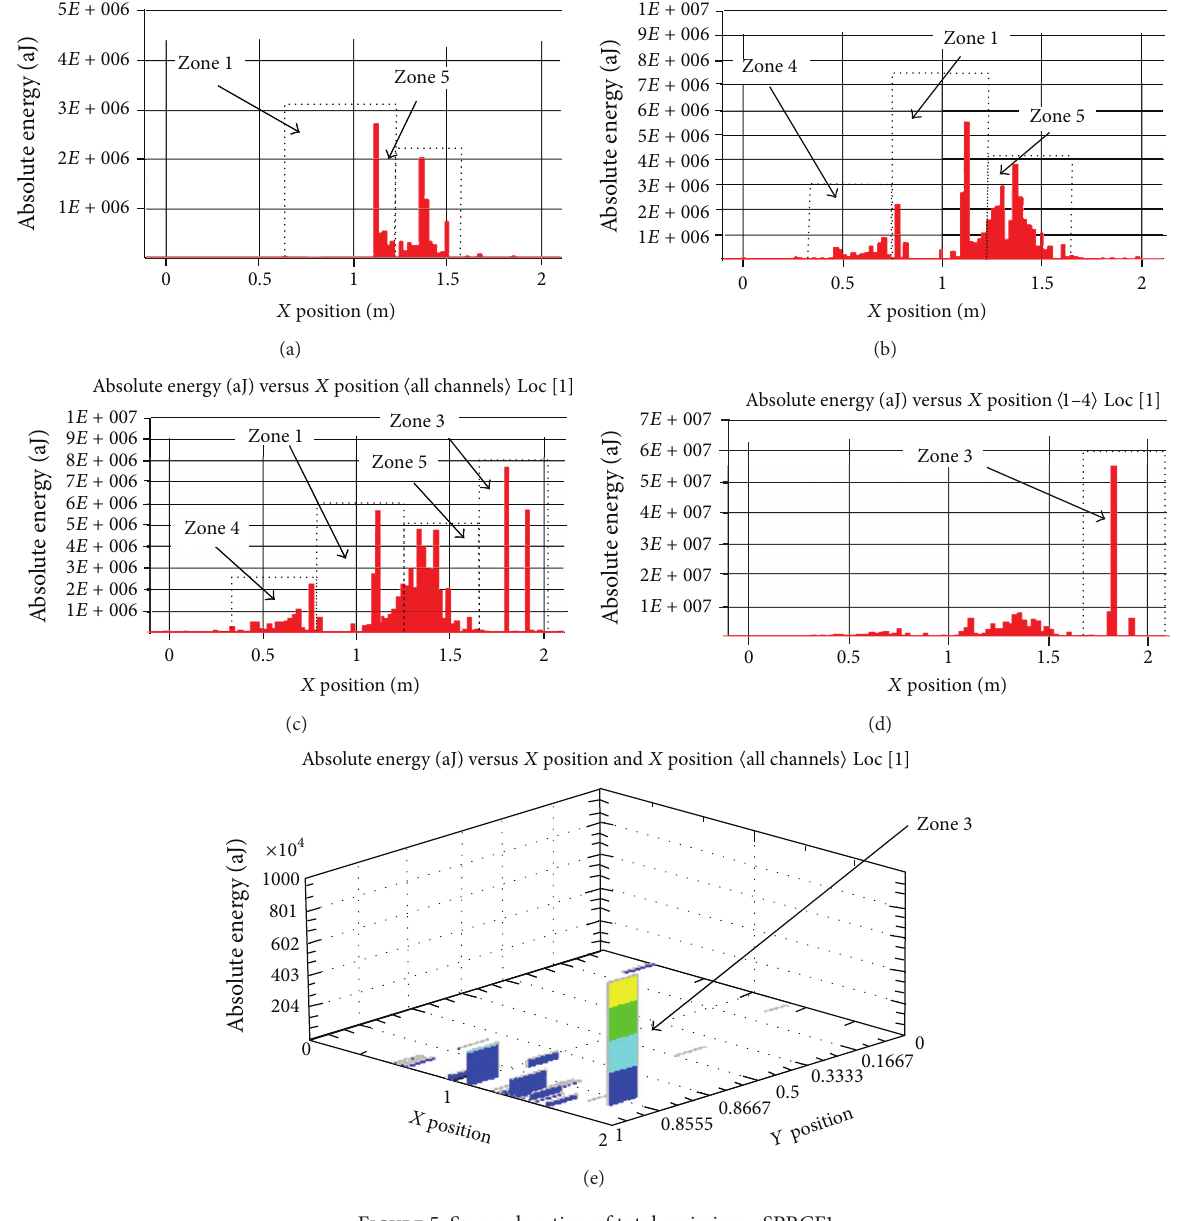
Figure 5: Source location of total